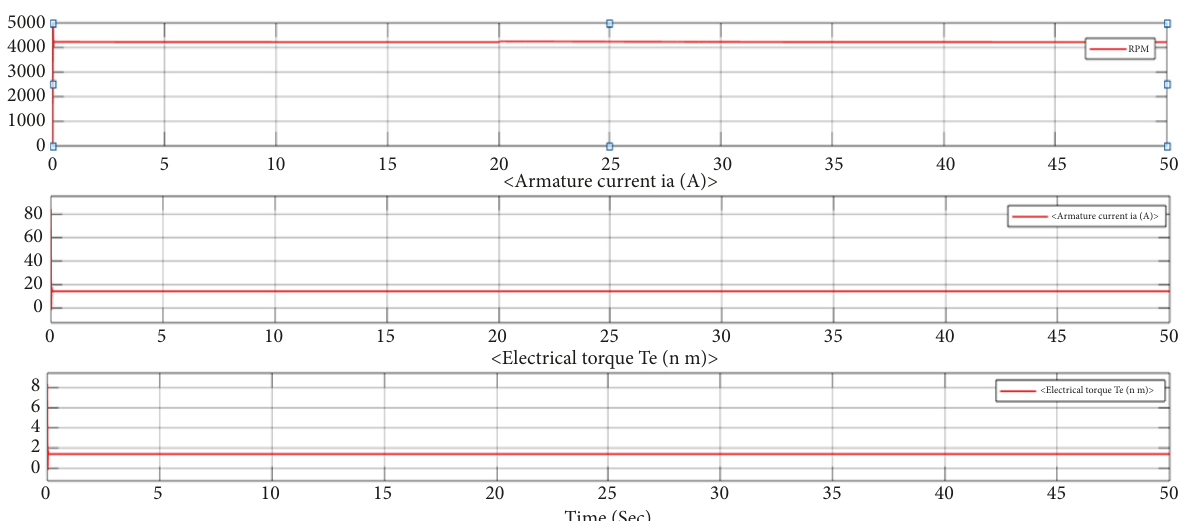
Figure 22: PMDC motor